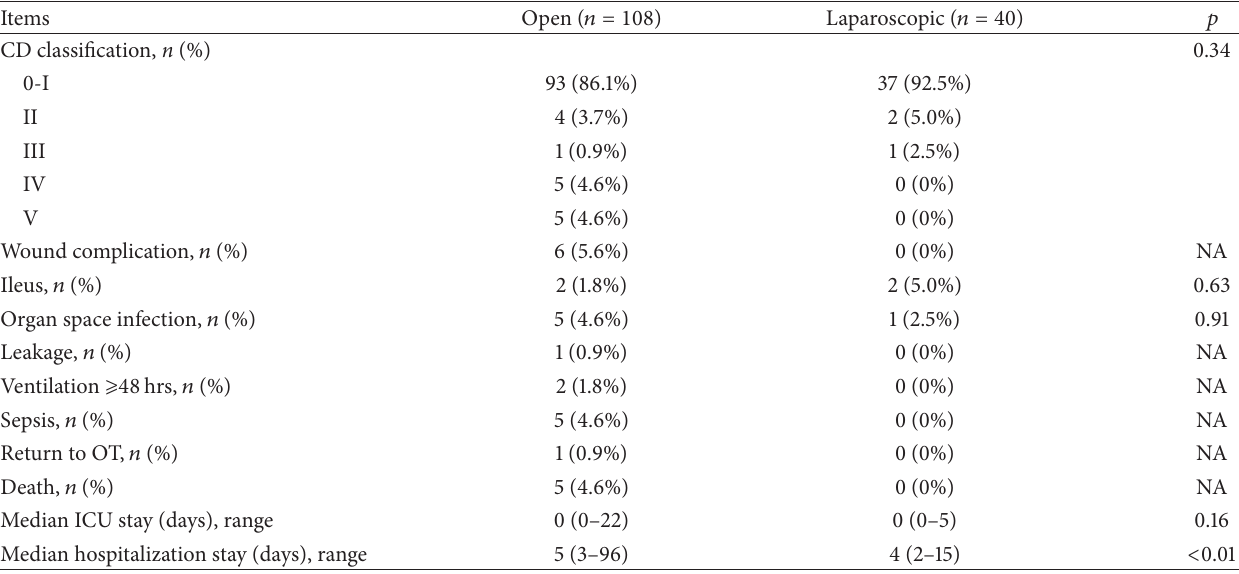
Table 2: Perioperative comparison between open and laparoscopic repair of perforated peptic ulcer.